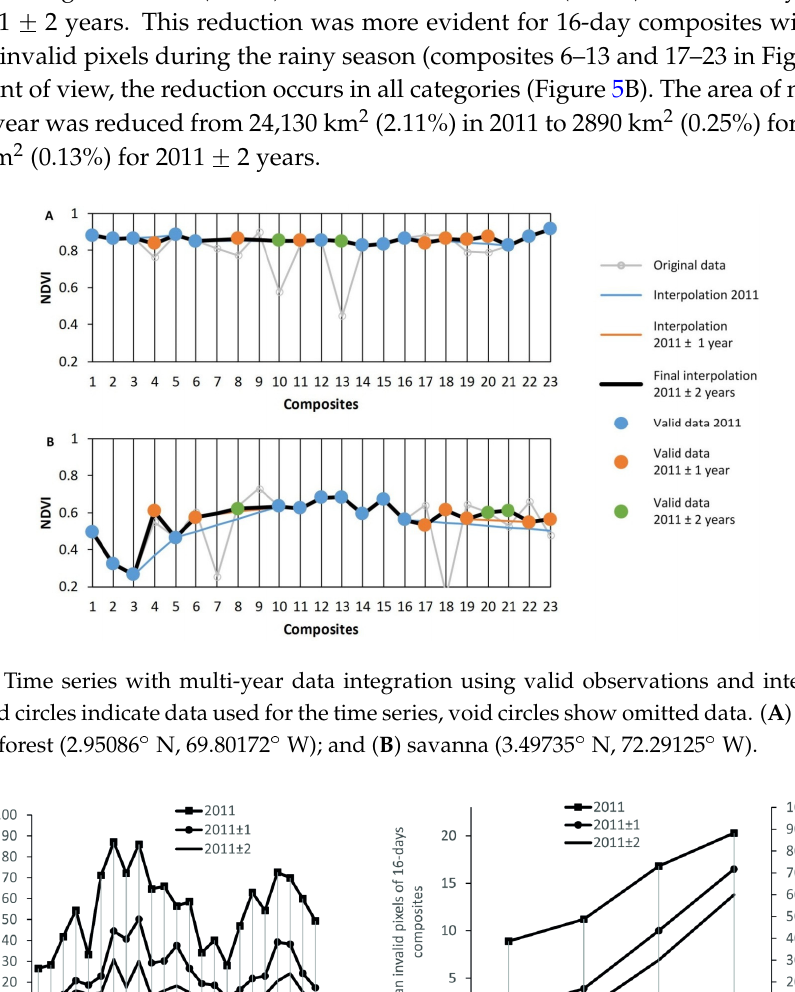
Remote Sens. 2015 , 7